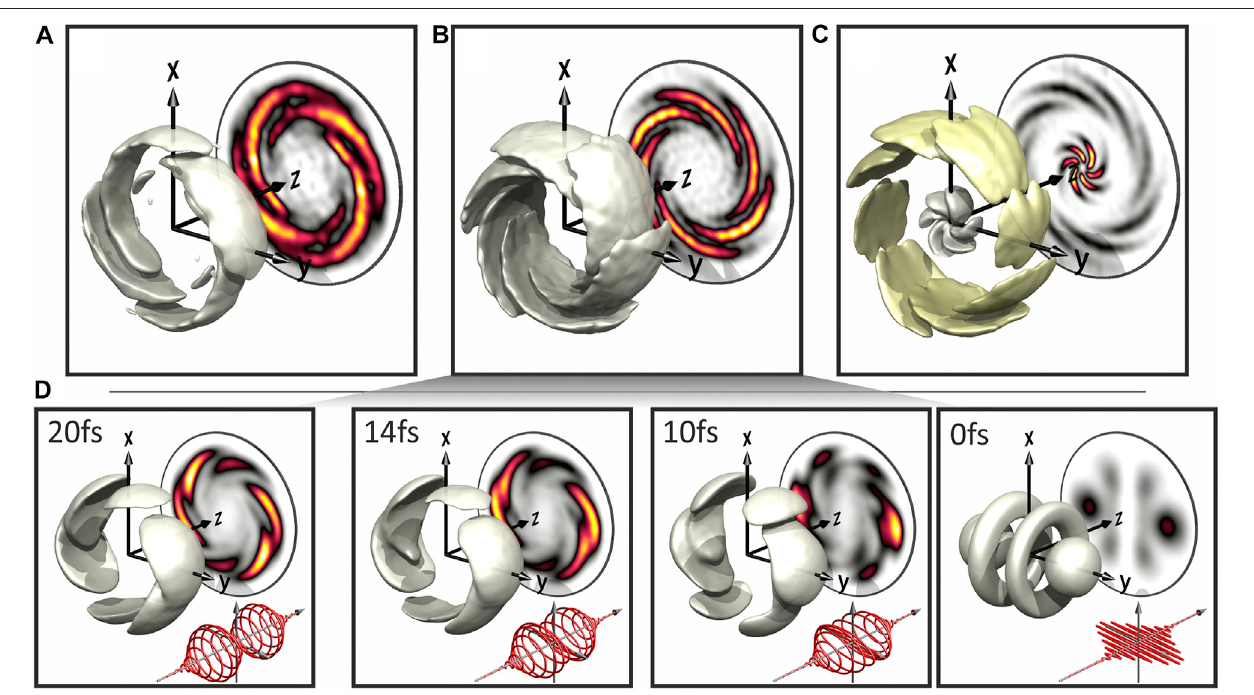
FIGURE 6 | Tomographically reconstructed Archimedean spiral-shaped FEVs with c 4 , c 6 and c 8 rotational symmetry from 1 + 2 REMPI of potassium atoms using single-color CRCP pulses along with their projection in the z -direction [103]. (A) Non-perturbative REMPI with a sequence of two π pulses creates a FEV with four arms. (B) Perturbative REMPI gives rise to a six-armed FEV. (C) Absorption of an additional photon in the continuum results in an eight-armed FEV in the ATI. (D) Evolution of the